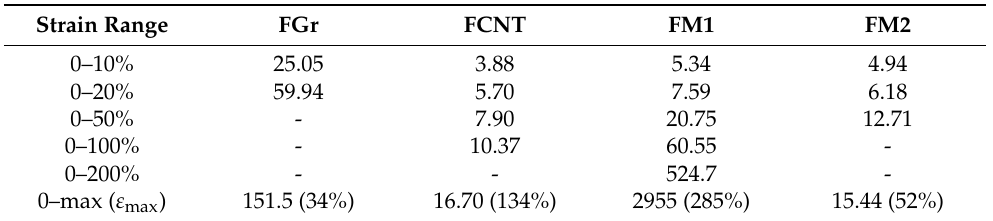
Table 2. Gauge factor (GF) of the various composite filaments within several strain ranges. The last row describes the gauge factor of each filament for maximal strain as measured by piezoresistive testing (Figure 3).